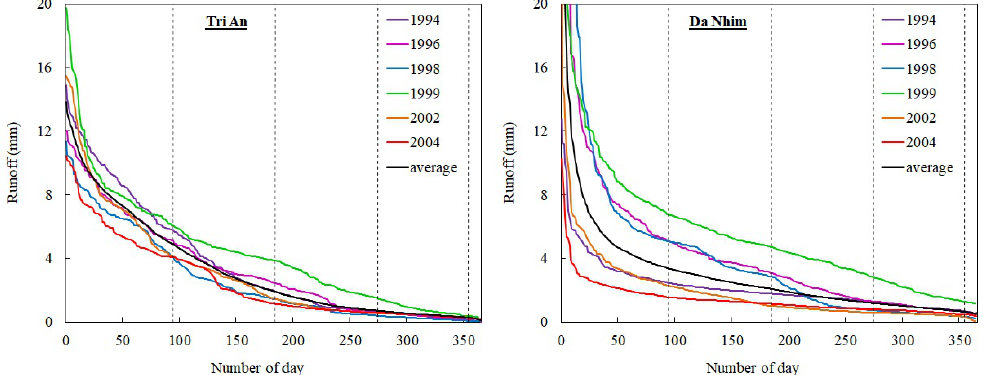
Figure 5. Annual FDCs of Tri An and Da Nhim.